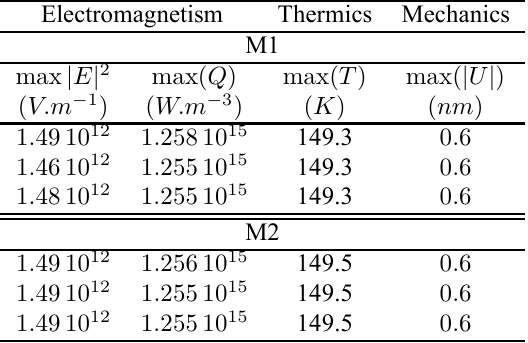
Table 2: Convergence for the variables of interest. The in- coming field intensity being | E 0 | 2 = 4 . 48 . 10 10 . The com- putations are made for a 10 nm gap and corresponds to the precisions indicated in Tab.